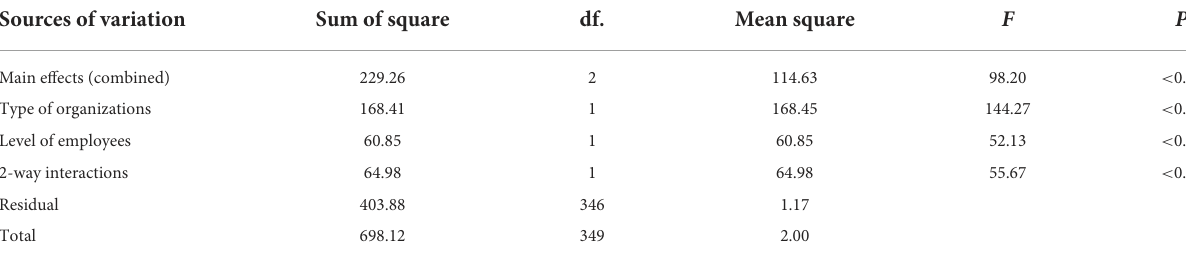
TABLE 8 Summary of two-way ANOVA for nature of occupational stress by type of organizations and level of employees ( N = 350). Sources of